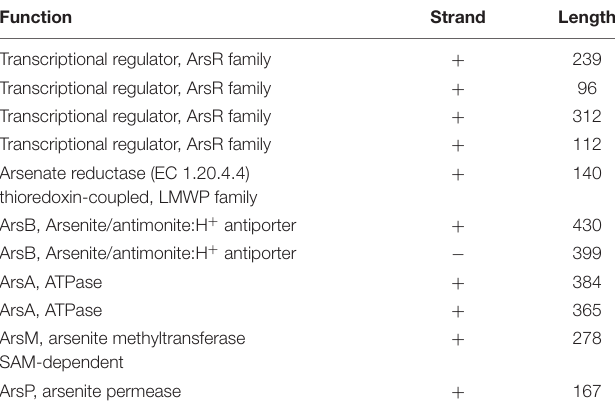
TABLE 4 | Annotation, strand, and length of the predicted arsenic resistance genes. Function Strand